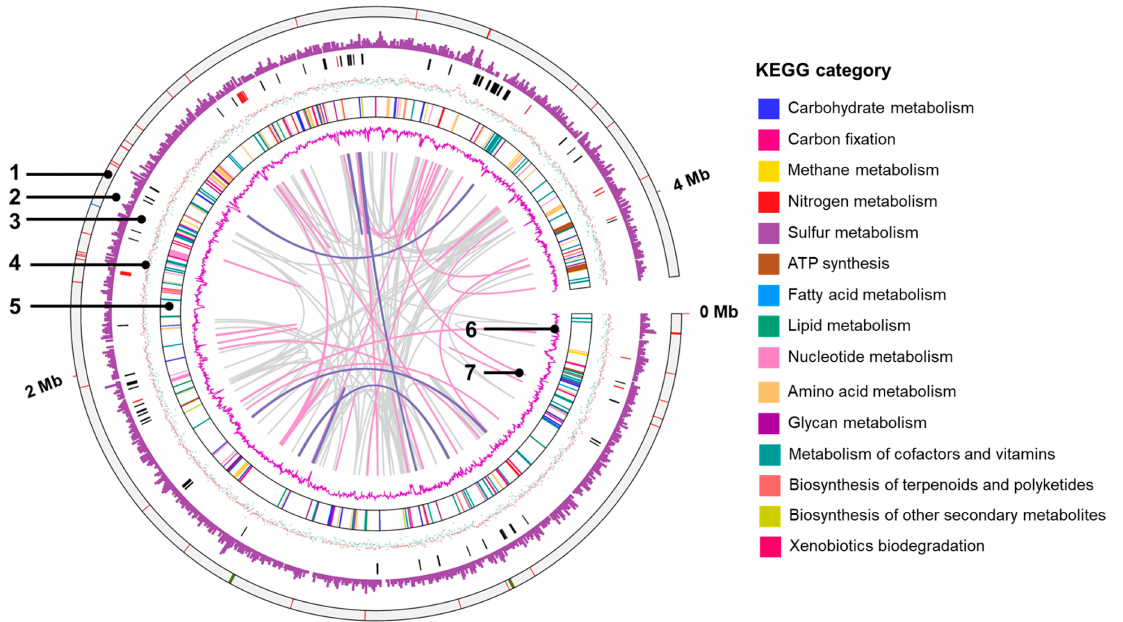
Figure 3. Features of the complete genome of strain NIT-SL11. Circular representation of the genome was generated using Tbtools-II (v1.106, https://github.com/CJ-Chen/TBtools-Manual). Rings numbered from the outside to inside are: 1, location of tRNA (red), Transfer messenger RNA (blue), and rRNA (green); 2, gene density; 3, c-type cytochromes (black) and type IV pili (red); 4, G+C skew (red, positive; green, negative); 5, protein-coding sequences colored based on KEGG category; 6, G+C content; and 7, links showing repetitive sequence ≥ 95% identity (pink, >500 bp; purple, >2 kbp). KEGG, Kyoto Encyclopedia of Genes and Genomes.